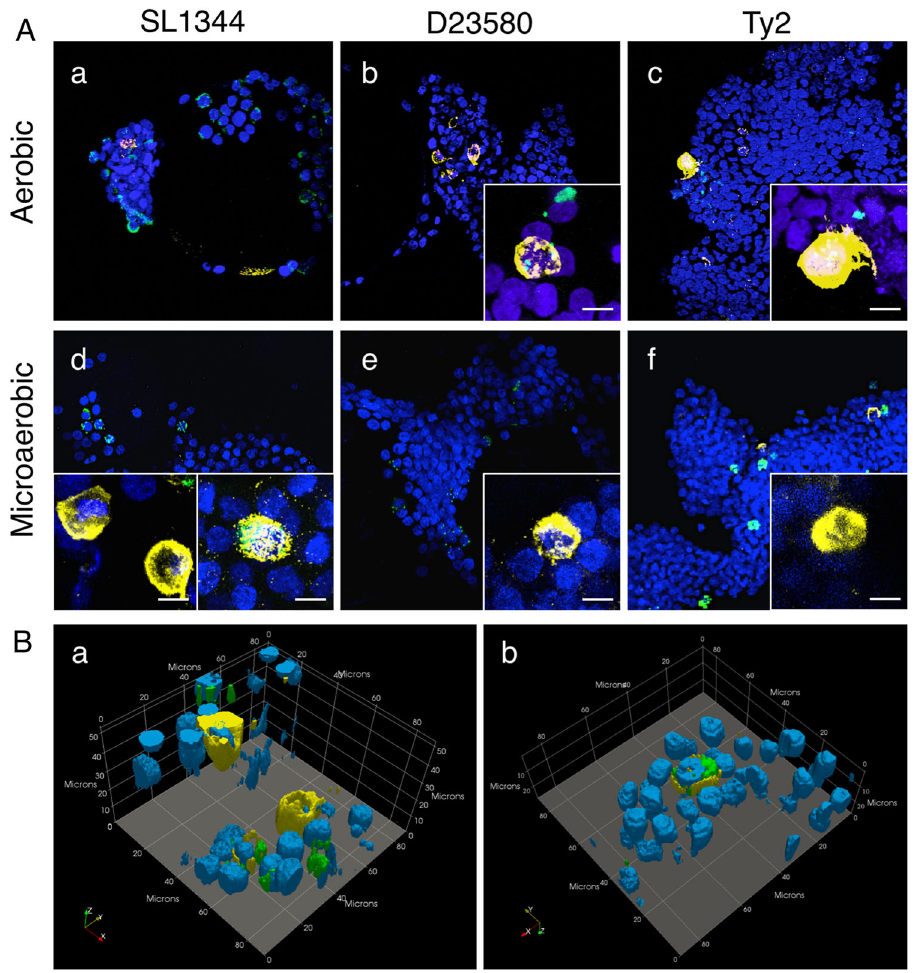
Fig. 6 Different co-localization patterns of Salmonella pathovars in the 3-D co-culture model. A Cells were fi xed 24 h.p.i. with SL1344 ( a , d ), D23580 ( b , e ) or Ty2 ( c , f ) that were cultured aerobically ( a – c ) or microaerobically ( d – f ). Time-matched uninfected control is shown in (Supplementary Fig. S6). Samples co-stained with CD45 antibody ( macrophages, yellow ) and anti- Salmonella antibody ( green , appears white when overlaid with CD45 signal). Cell nuclei stained with DAPI ( blue ). Insets highlight representative co-localization patterns for bacteria and macrophages. When SL1344 was grown microaerobically, macrophages were either empty ( d , left inset ) or contained internalized bacteria ( d , right inset ). When D23580 and Ty2 were grown microaerobically, the majority of the macrophages were empty (insets). Magni fi cation = 400×. Scale bar = 10 µm. B 3-D perspective of ( d ) insets showing a empty macrophages and b SL1344-containing macrophages. Image generated in